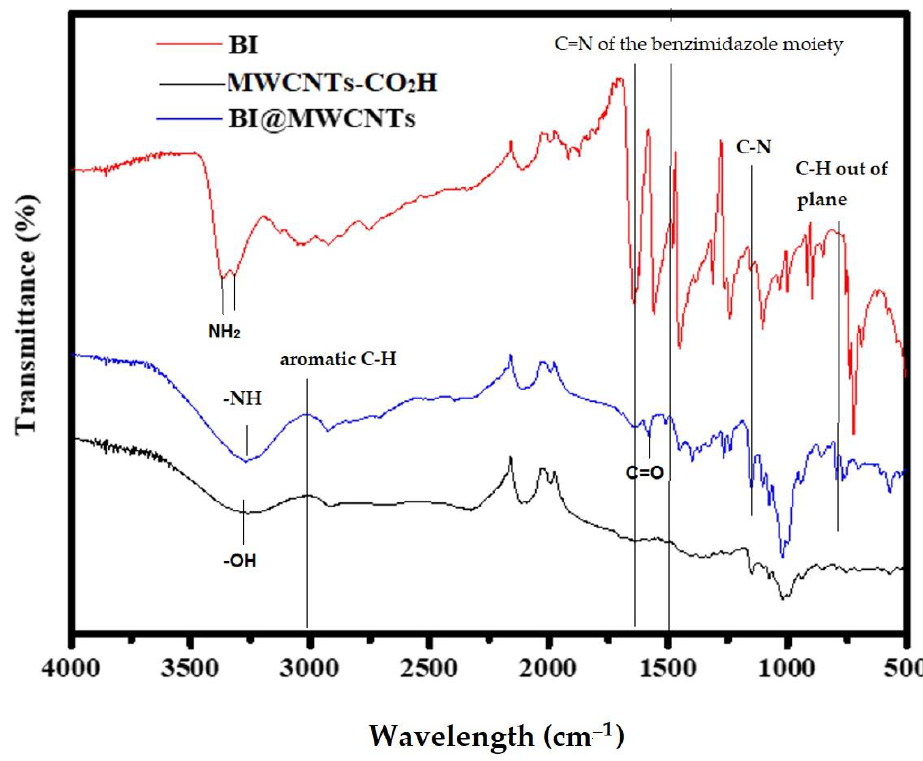
Figure 1. FTIR spectra of BI, MWCNTs – CO 2 H, and BI@MWCNTs.